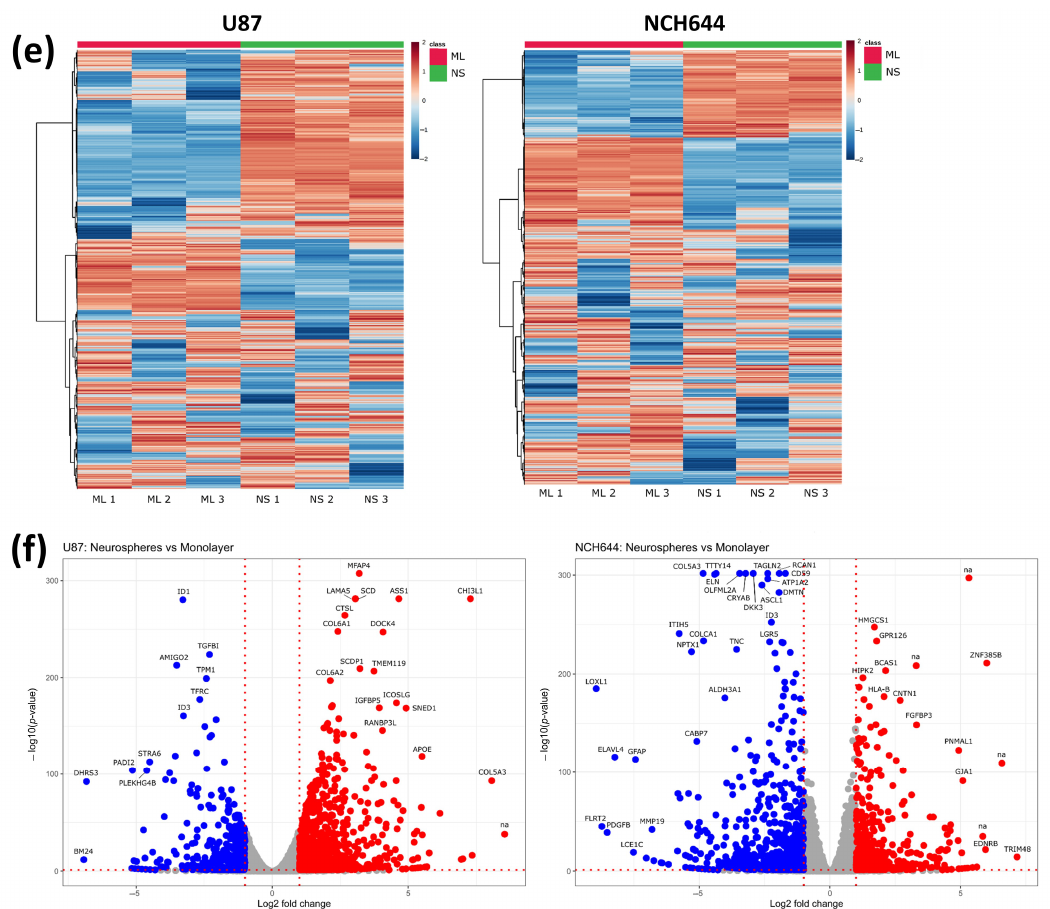
Figure 1. Transcriptomics analysis of monolayer (ML) and neurospheres (NS) from U87 and NCH644 cells. ( a ) Represen- tative image of U87 and NCH644 NS cultured for four days, before cell harvesting for RNA and metabolite extraction. Scale bar = 150 µ m; ( b ) Principal component analysis and ( c ) hierarchical clustering of all genes, showing a clear separation between ML and NS samples in both cell lines. ( d ) Venn diagram depicting the number of significantly upregulated (UP) and downregulated (DN) genes in NS vs. ML, as well as the number of commonly and differentially regulated genes between U87 and NCH644 cells (FDR < 0.05, log2FC > ± 1). ( e ) Heatmaps and ( f ) volcano plots of upregulated (red) and downregulated (blue) genes in NS vs. ML from U87 and NCH644 cells (FDR < 0.05, log2FC > ± 1); n =